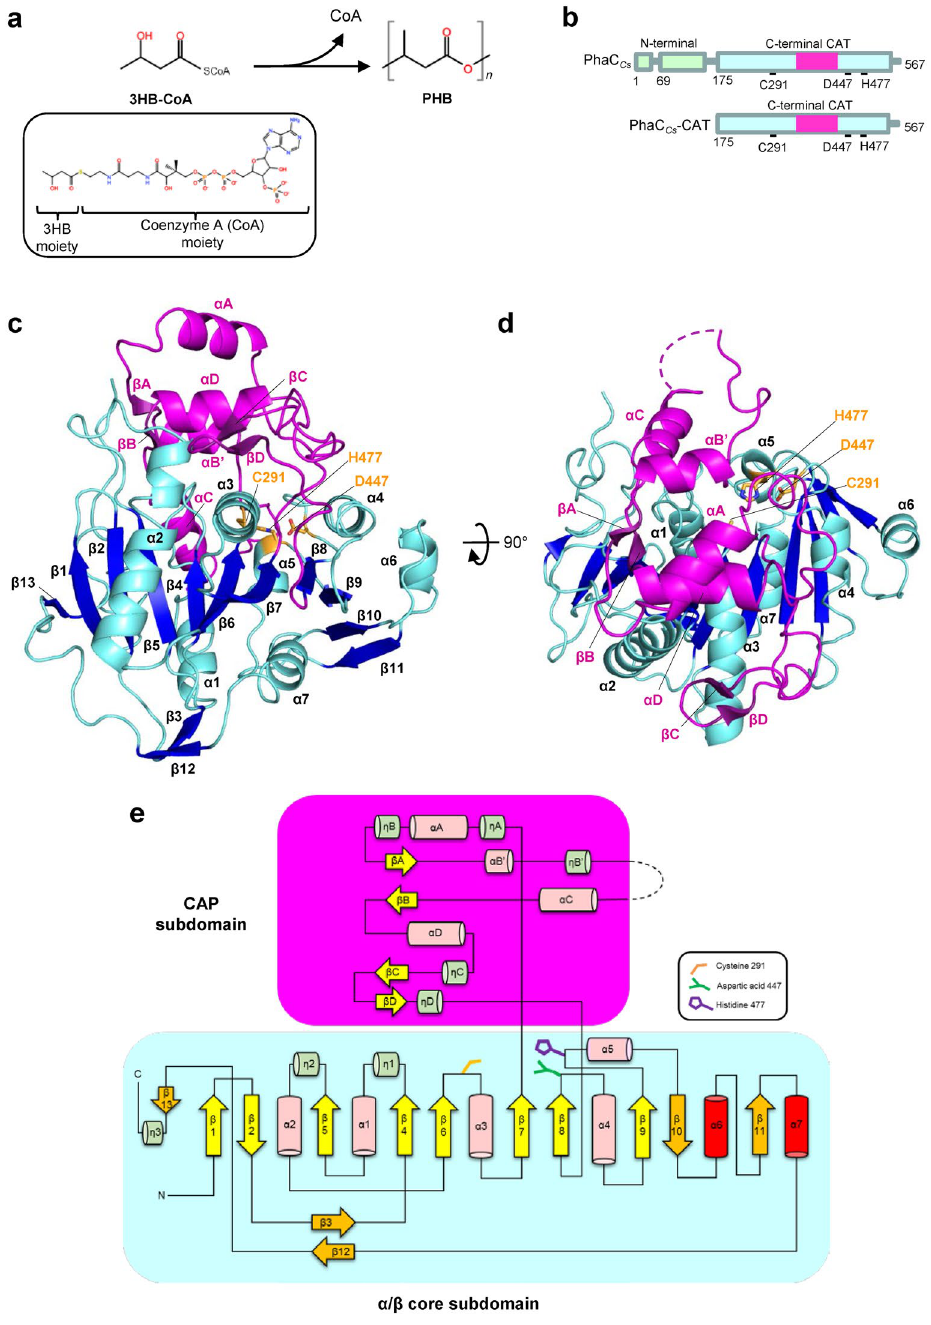
Figure 1. Structure of PhaC Cs -CAT. ( a ) Polymerization reaction catalyzed by PhaC. Polymerization of the substrate, 3-hydroxybutyryl coenzyme A (3HB-CoA), into poly 3-hydroxylbutyrate (PHB) is catalyzed by PhaC with release of CoA. The chemical structure of 3HB-CoA is shown in the inset. ( b ) Domain organization of PhaC Cs . PhaC Cs consists of two domains, the N-terminal domain which is important for stabilizing dimeric PhaC and the C-terminal catalytic (CAT) domain containing conserved active site including triad residues Cys, His and Asp. ( c ) A side view of PhaC Cs -CAT. The catalytic domain of PhaC Cs comprises the α / β core subdomain (residues 175–318, 439–562 in cyan) and the CAP subdomain (residues 319–438 in violet). The side chains of the catalytic triad (Cys291, His477 and Asp447) are shown in orange. ( d ) As in b, but a top view of PhaC Cs -CAT. The active site is covered by the CAP subdomain. ( e ) Schematic presentation of the secondary structure topology of PhaC Cs -CAT (mol B). The CAT domain contains the CAP and core subdomains. The core subdomain comprises 13 strands and 10 helices. Nucleophilic Cys291 is located between β 6 and α 3, conserved His477 is located between β 9 and α 5, and Asp447 is located between β 8 and α 4. The CAP subdomain is connected from β 7 and back to the core domain through β 8. The catalytic triad is covered by the CAP subdomain which blocks the substrate entry pathway. The other strands (orange) and helices (red) shown represent additional secondary structures observed when comparing the canonical α / β hydrolase